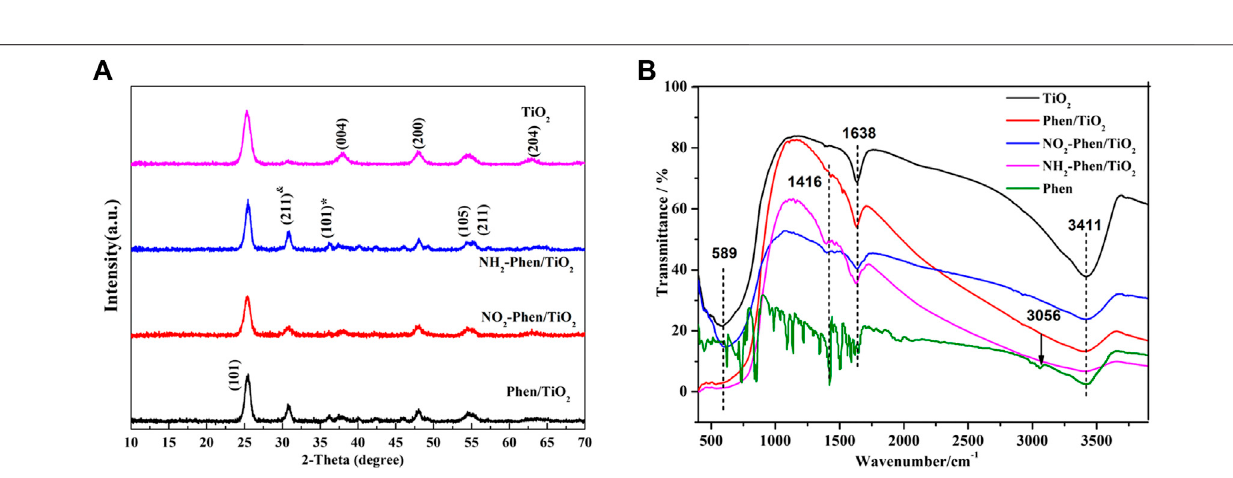
Frontiers in Chemistry |